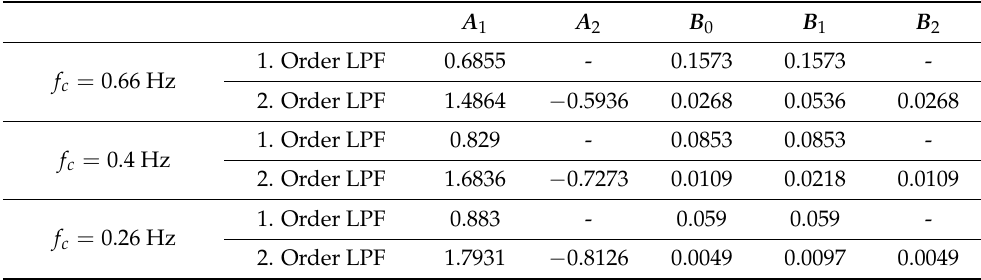
Table 1. Parameters for the low pass